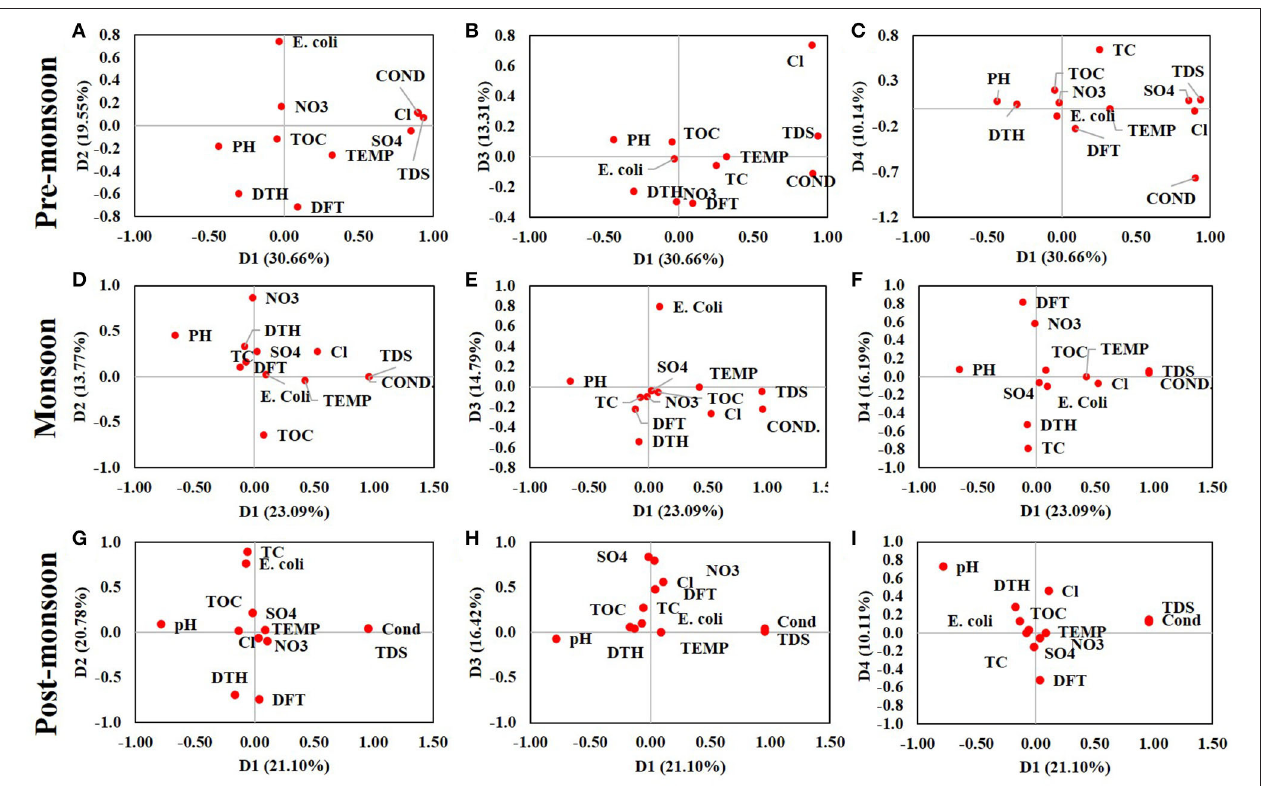
FIGURE 5 | Plot of the correlations between variables and factors after Varimax rotation in pre-monsoon, monsoon, and post-monsoon seasons from principal component analysis of the entire data set. (A) D1 vs. D2, (B) D1 vs. D3, and (C) D1 vs. D4 representing the relationship among the variables during the pre-monsoon season, (D) D1 vs. D2, (E) D1 vs. D3, and (F) D1 vs. D4 representing the relationship among the variables during the monsoon, and (G) D1 vs. D2, (H) D1 vs. D3, and (I) D1 vs. D4 representing the post-monsoon